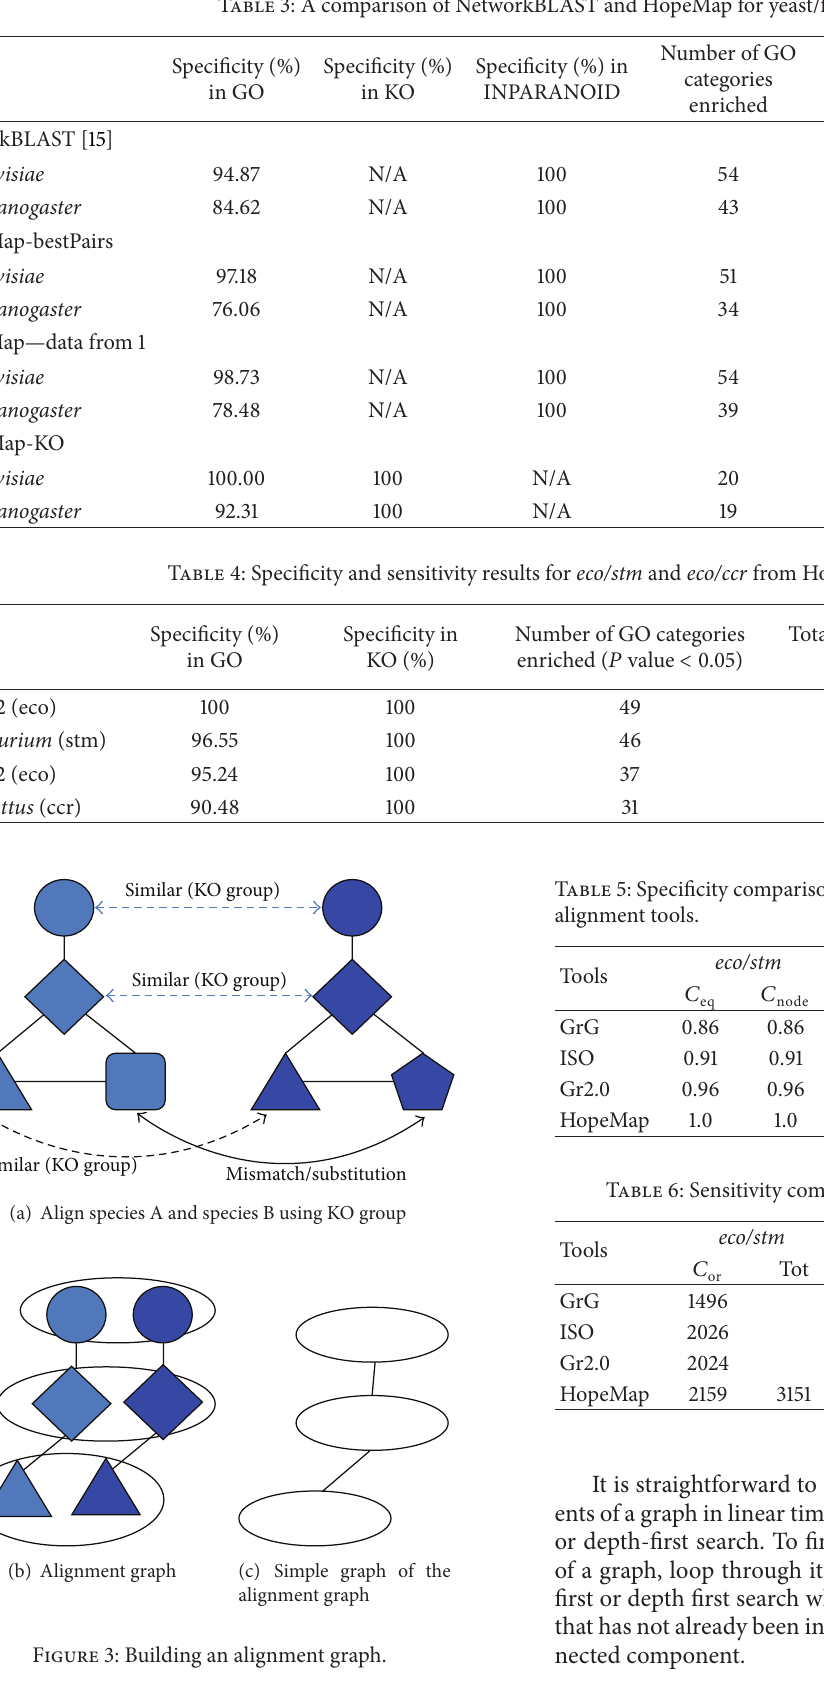
Table 3: A comparison of NetworkBLAST and HopeMap for yeast/fly.